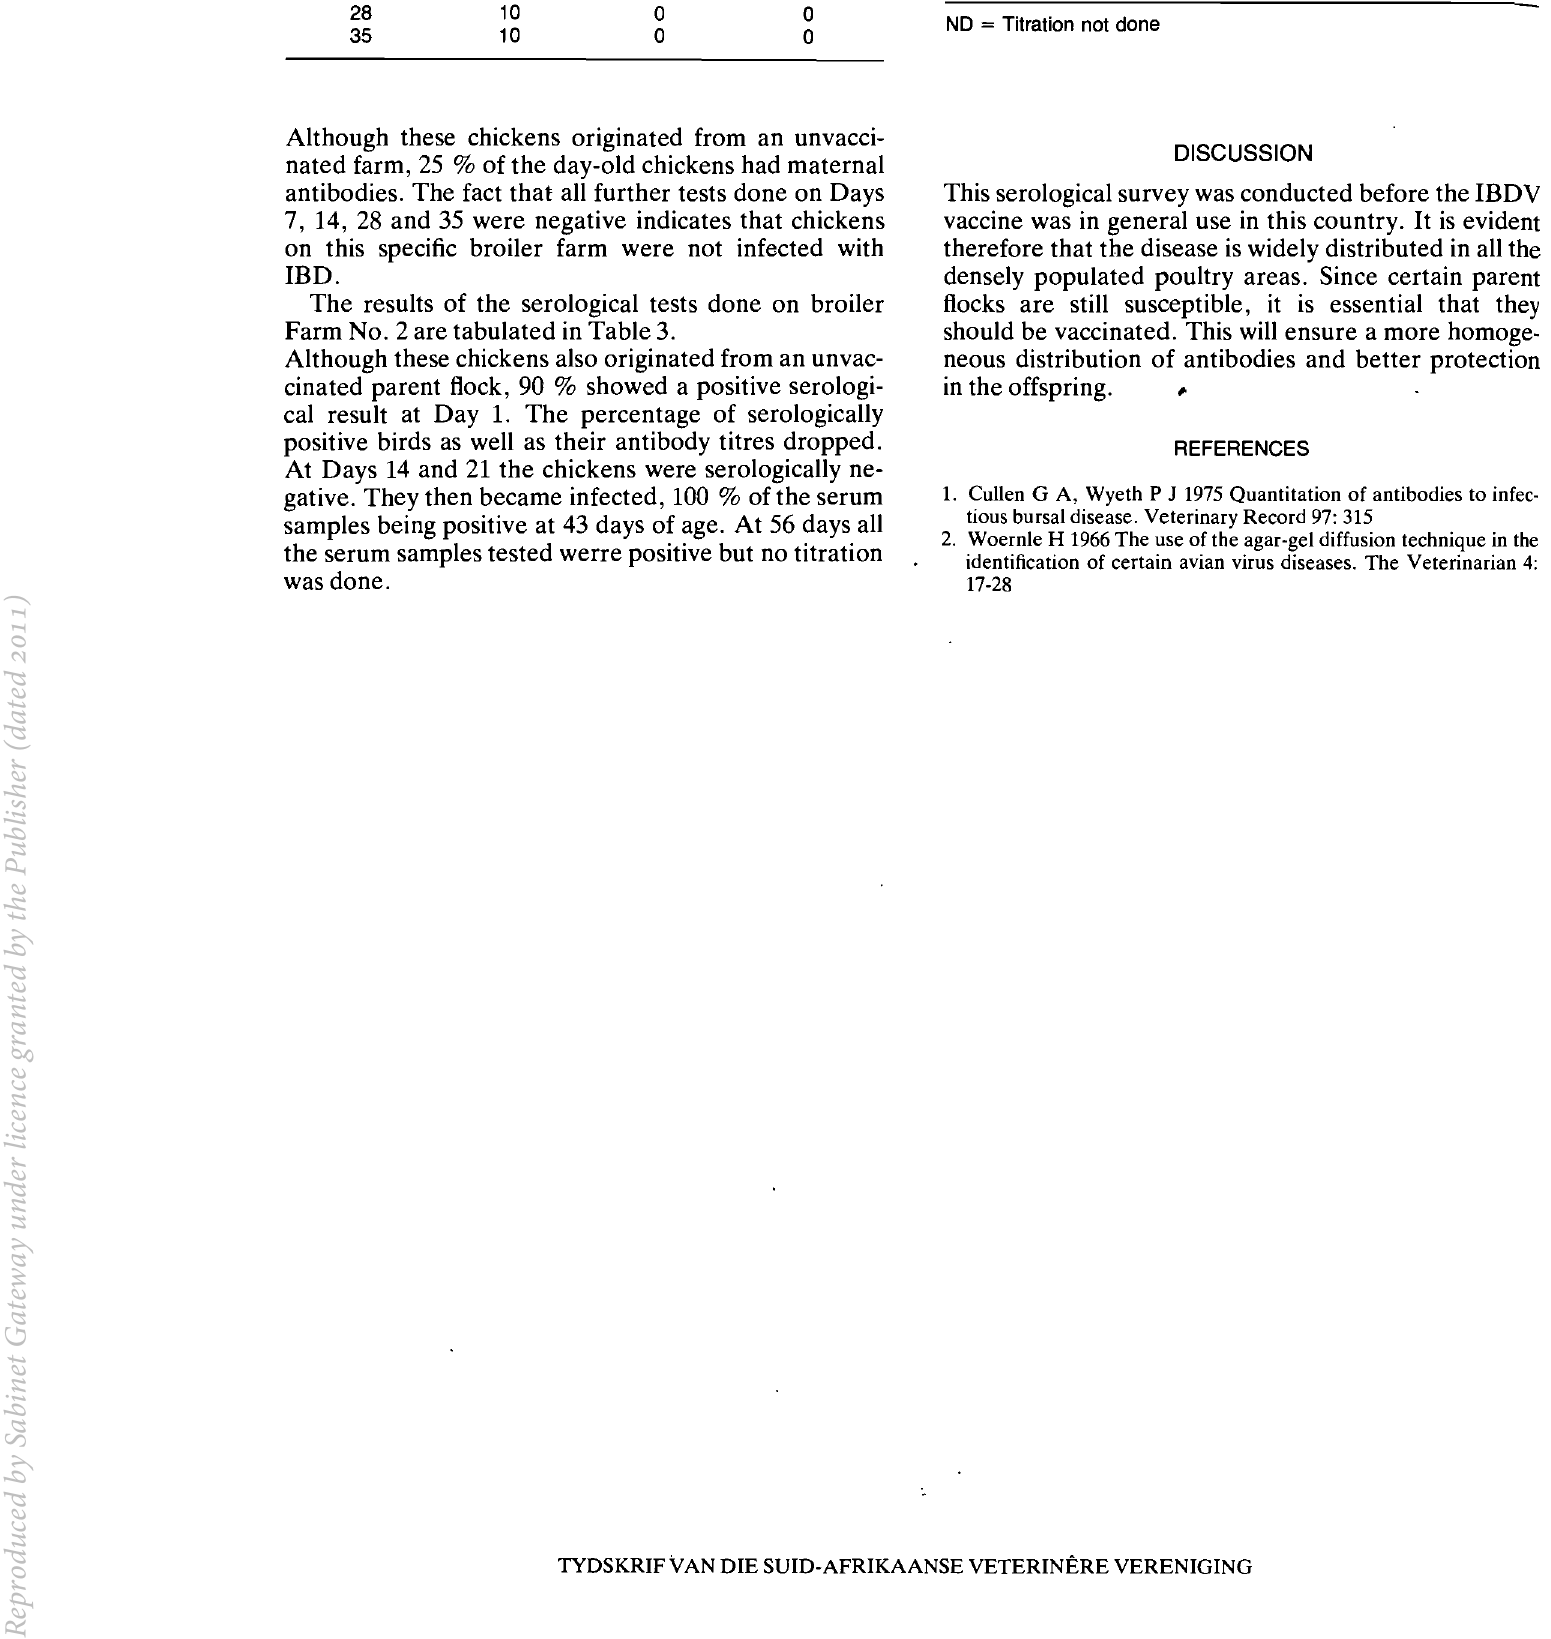
Table 2: DISTRIBUTION OF PRECIPITATING ANTIBODIES AGAINST IBDV ON FARM No.1 IN A FLOCK AT DIFFERENT AGES